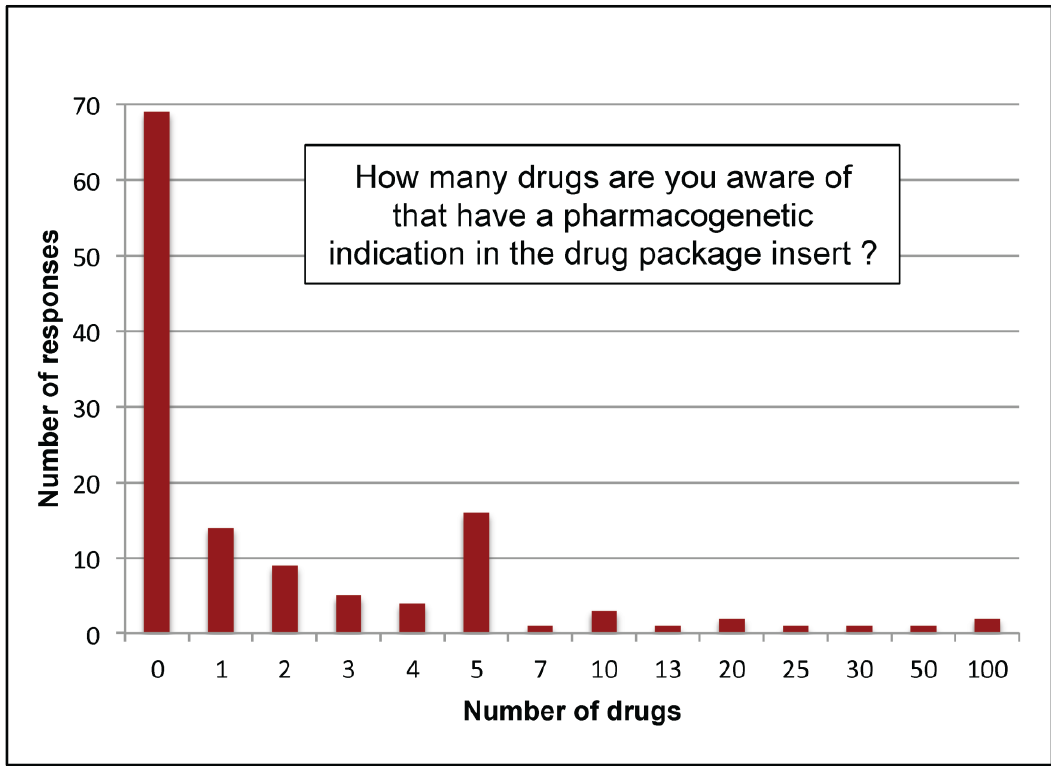
Figure 2. Awareness of pharmacogenetic indications. Respondents ( N = 129) were asked how many drugs they were aware of with a pharmacogenetic indication in the labeling and were provided a blank field to enter a numeric answer. At the time of the survey, there were over 130 drugs reviewed by FDA with pharmacogenetic labeling information